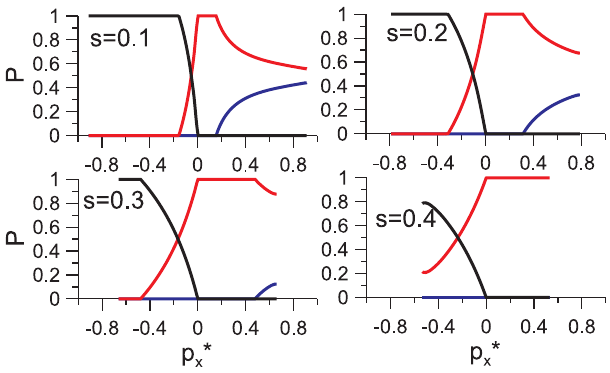
Fig. B1. Probabilities of capture P 1 (red), P 2 (blue) and P = 1 − P 1 − P 2 (black) are shown as functions of the parameter p ∗ x along the uncertainty curve for various s .